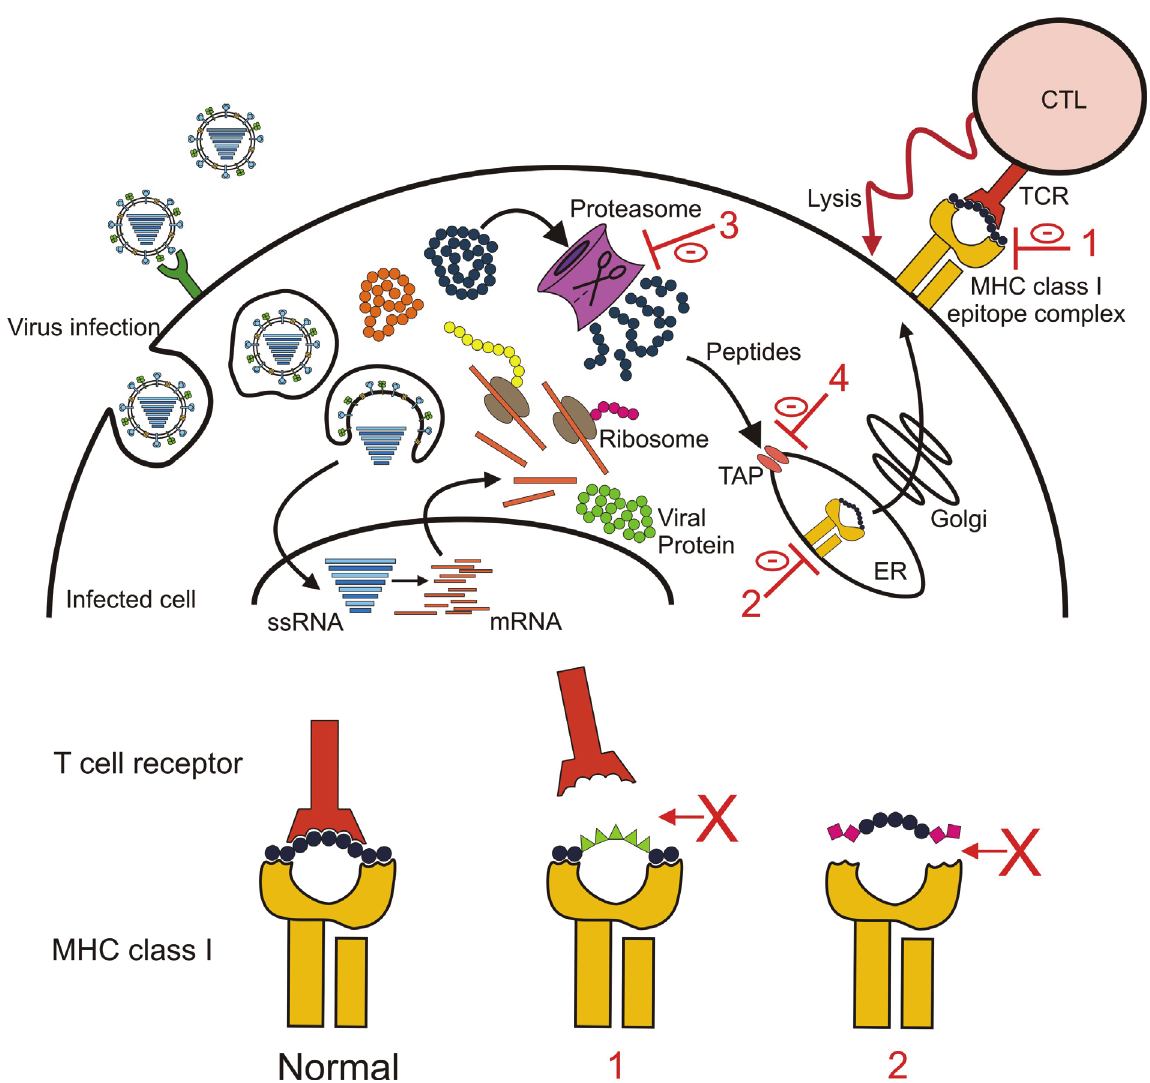
Figure 5. MHC class I presentation of influenza A virus epitopes and viral escape. This figure represents a virus-infected cell and the presentation of viral epitopes by MHC class I molecules. The virus can escape recognition by virus specific CTLs by: ( 1 ) Mutations in TCR contact residues of CTL epitopes in order to prevent recognition of the epitope MHC class I complex by specific CTLs, or ( 2 ) mutating the anchor residues of the CTL epitope which prevents binding of the epitope to MHC class I molecules. Furthermore, mutations outside the CTL epitope may affect antigen processing by the proteasome or transport via the TAP respectively ( 3 and 4